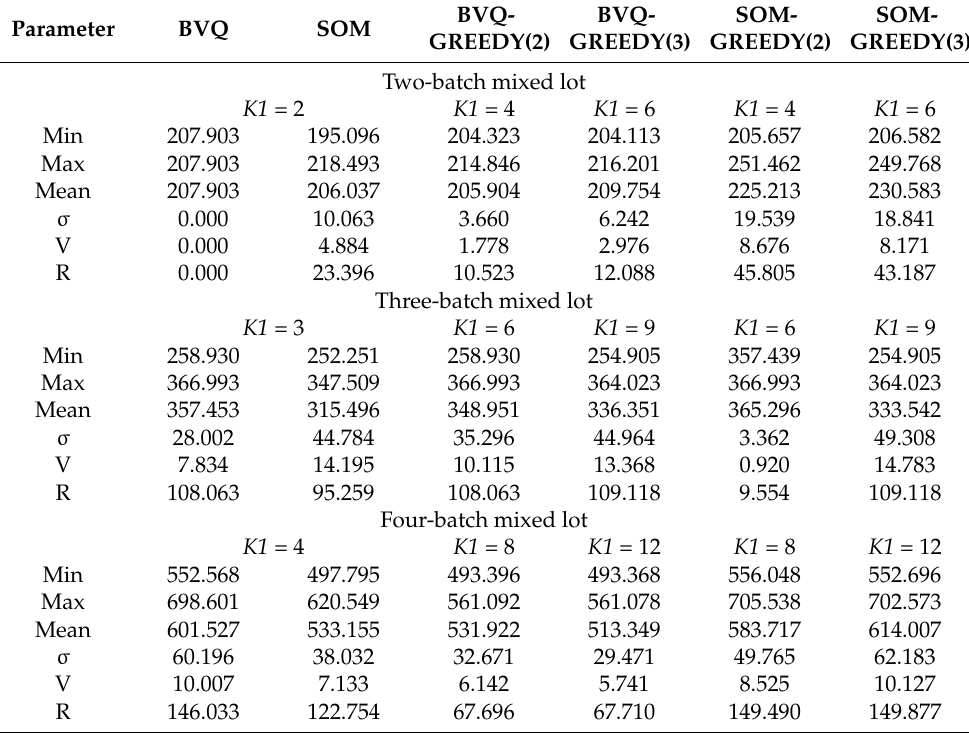
Table A3. Objective function value summarized after 30 attempts (Chebyshev distance, initialization by random).